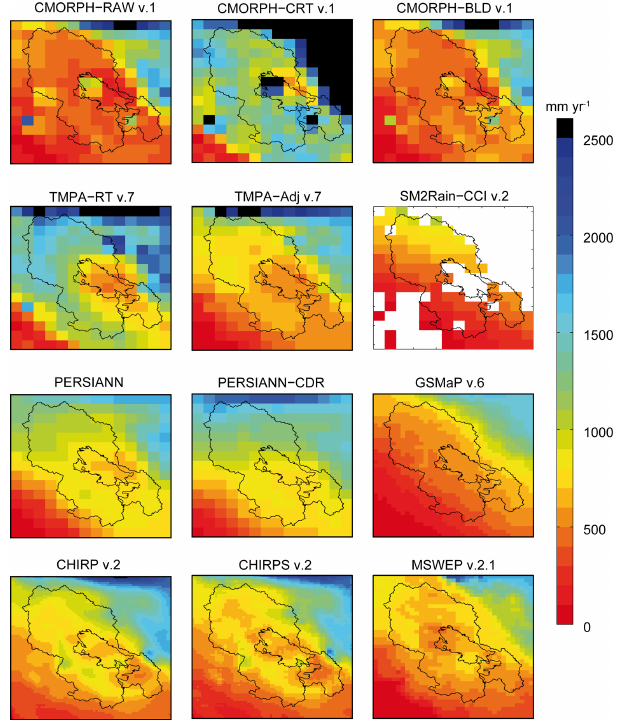
Figure 2. Mean annual precipitation maps for the 2000–2012 pe- riod retrieved from all SPPs at their original grid size. For each SPP, only the grid cells with more than 80% available daily data were retained. In order to keep the regional precipitation pattern visible, black colour was used to filter grid cells whose mean annual precip- itation was greater than 2500mmyr − 1